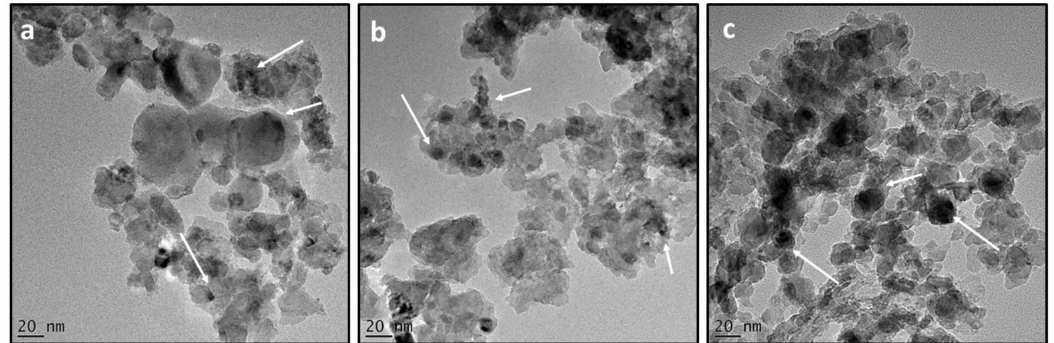
Figure 11. TEM images of Ni/MgAl 2 O 4 sulfided with DMSO (S3) at ( a ) 200 ◦ C, ( b ) 400 ◦ C, and ( c ) 550 ◦ C. Nickel-sulfided species indicated by white